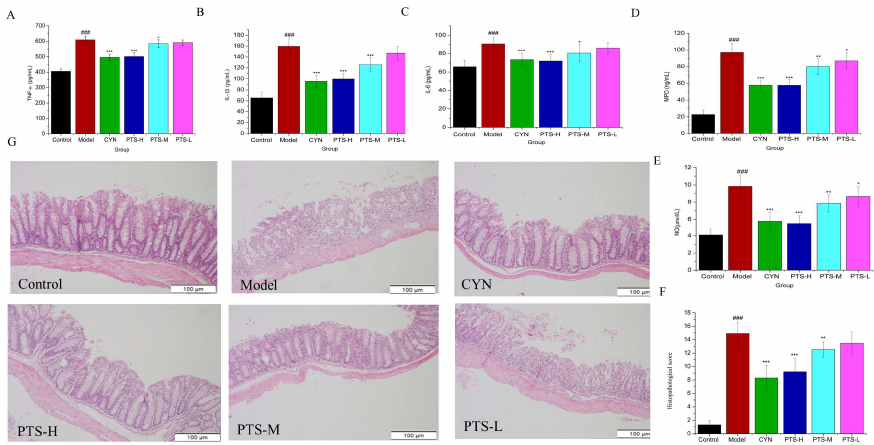
Figure 3. Results of the ELISA analyses: ( A ) TNF-α in serum in the six groups; ( B ) IL-6 in serum in the six groups; ( C ) IL-1β in serum in the six groups; ( D ) MPO in colon in the six groups; ( E ) NO in colon in the six groups; ( F ) histological score (n = 5); ( G ) representative images of hematoxylin and eosin (H&E)-stained colon tissues in mice of each group. Scale bar = 100 µm (n = 5). Data are expressed as the means ± SDs (n = 10). ### p < 0.001 vs. control. * p < 0.05, ** p < 0.01, and *** p < 0.001 vs. model